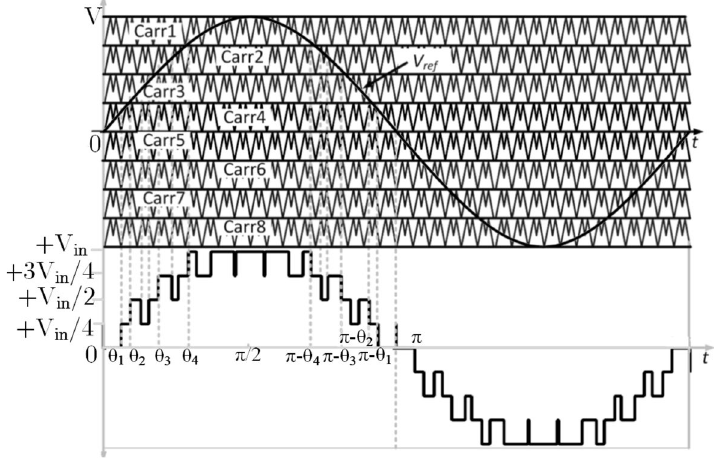
Figure 4. ( a ) Proposed multicarrier signal. ( b ) Typical 9L output voltage